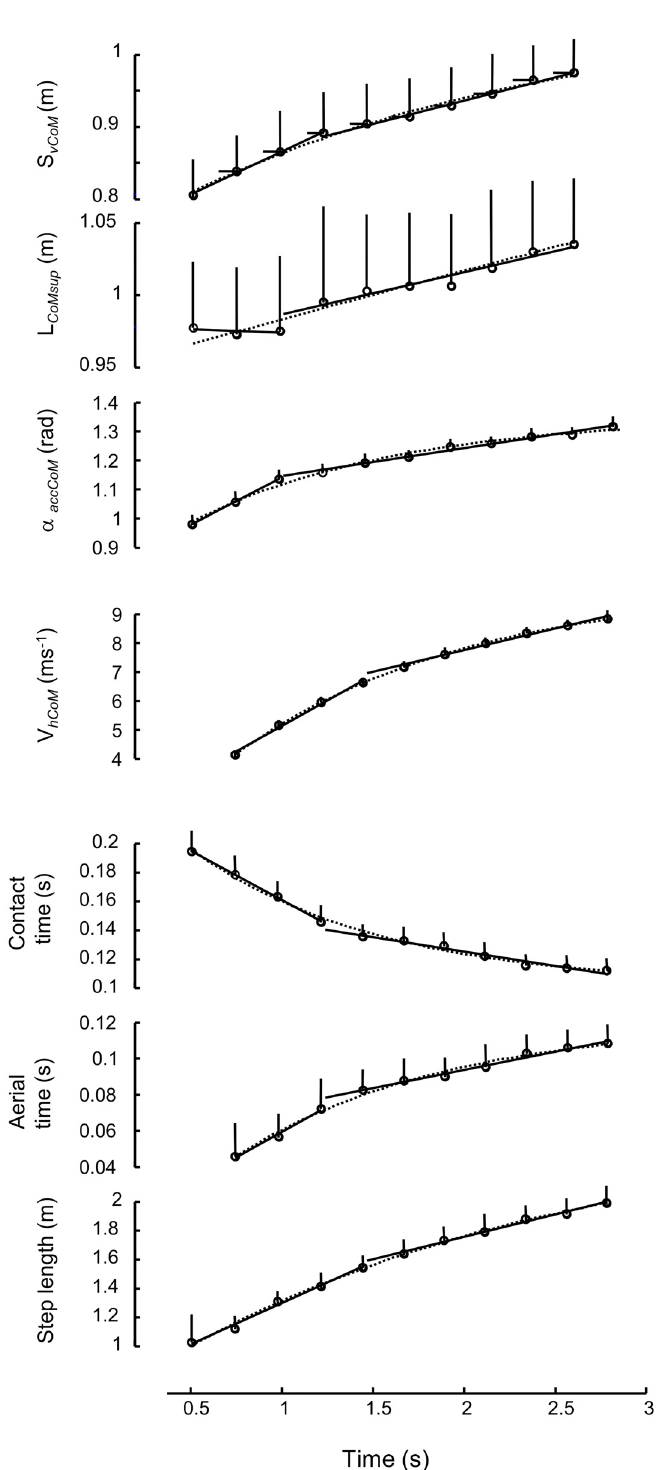
Fig 3. Curve fittings for the mean data for each step over all athletes. Only steps with a complete data set for the variable at hand are shown and were used for the fitting procedures. Dotted line: exponential; Solid lines: piecewise linear. Horizontal (top diagram only) and vertical bars are standard deviation (n = 24). Note that the seemingly very low standard deviation, especially for horizontal velocity, is only partly due to the homogeneous group and mainly due to scaling of the diagram, which covers low velocity at the first steps to almost maximal sprinting velocity. Time = 0 is the time of the first movement of CoM during the sprint start.